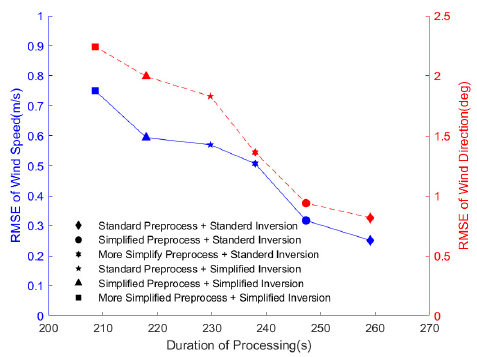
Figure 12. Cost of calculation vs. accuracy.